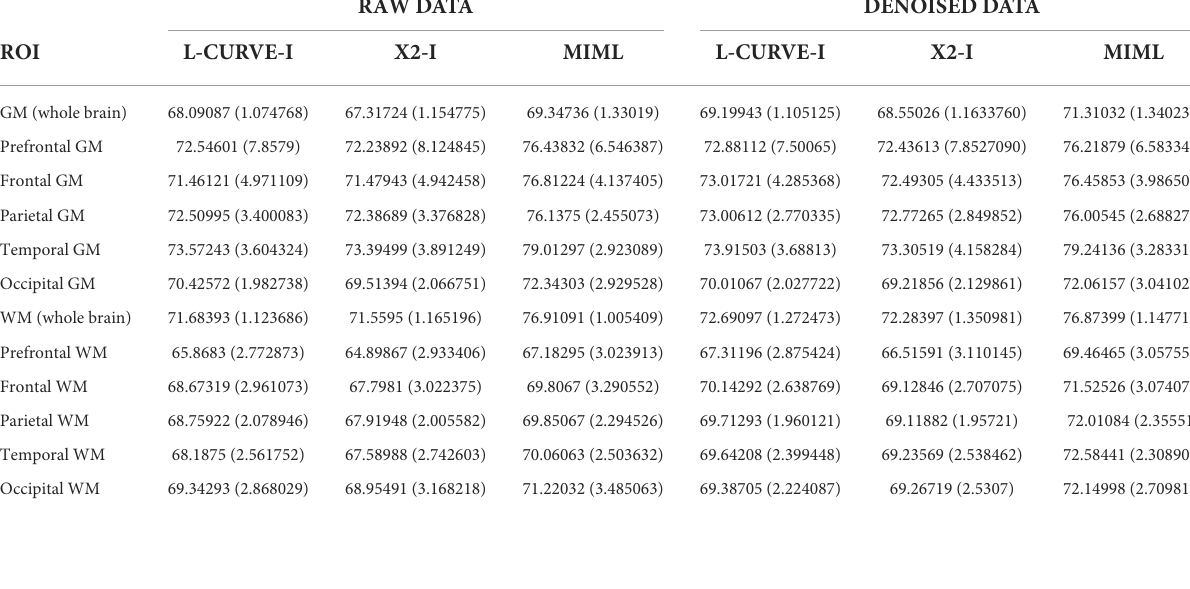
TABLE 1 T IE 2 mean (standard deviation) in WM and GM regions for all reconstruction methods under